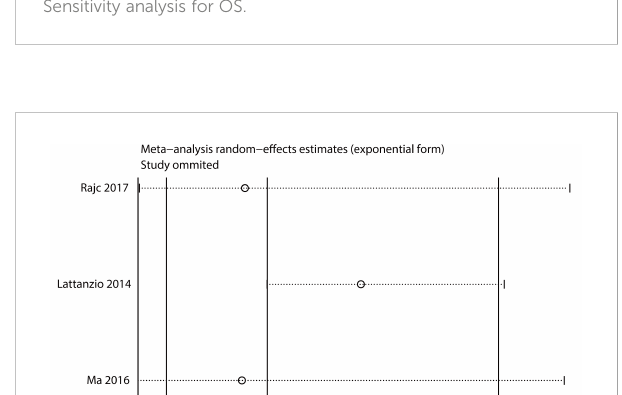
FIGURE 8 The publication bias for